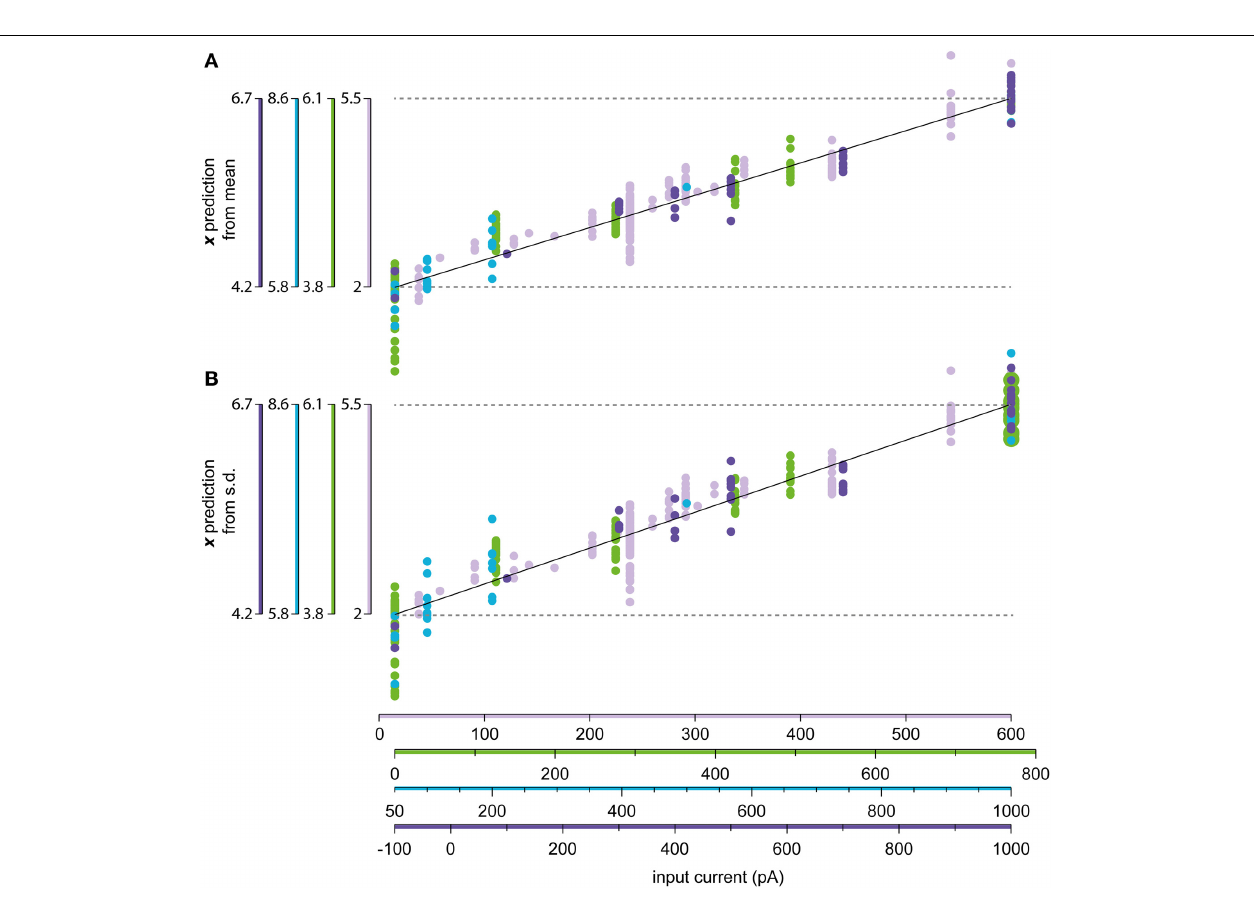
FIGURE 9 | Relationship between the injected current and the estimated input level. (A) Linear regression of the relationship between the normalized input x and the injection current I in Equation (6c). The mean of the firing